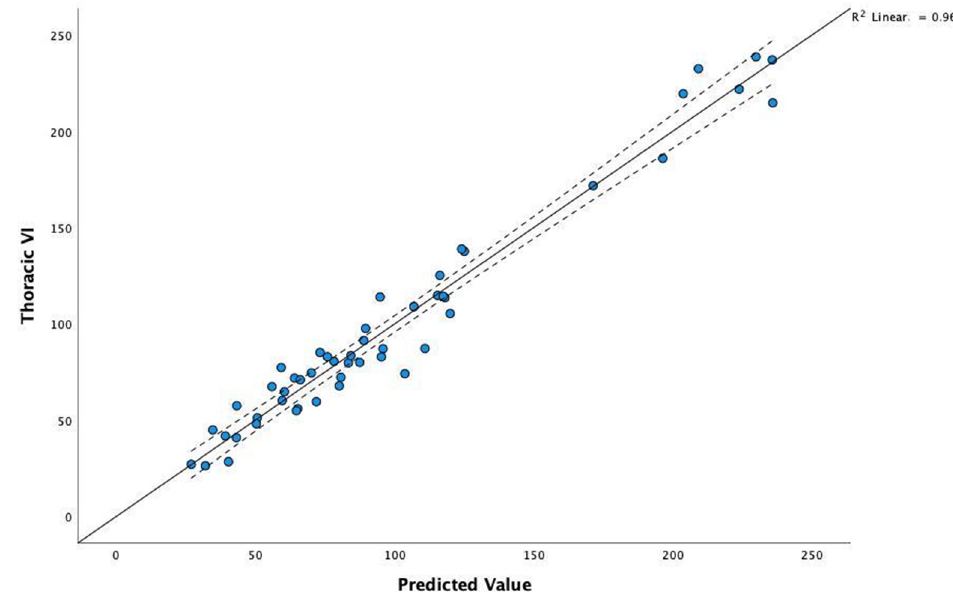
Figure 2. Correlation scatterplot of Thoracic VI for the observed values and those predicted by the model.